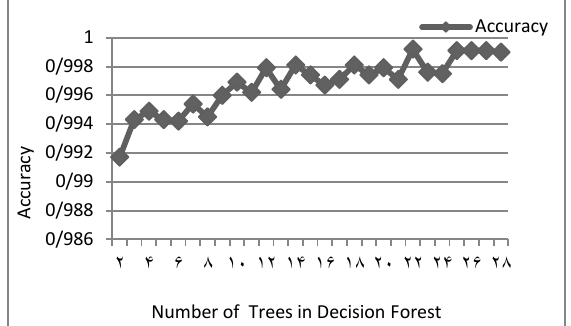
Figure 3. Assessing decision forest with different number of trees using accuracy.